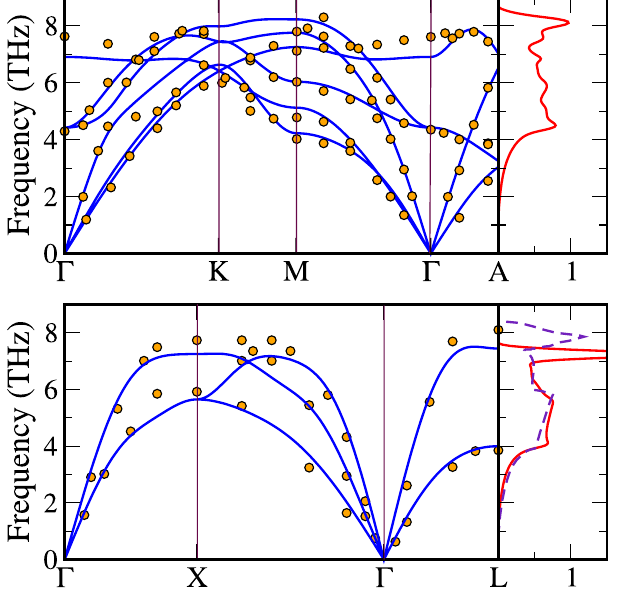
Figure 2. In the top-left panel the phonon dispersion relation along high symmetry lines for FM hcp Co is shown. The experimental values (dots) are taken from ref. 14. The calculated hcp phonon DOS is shown to the right of the figure. In the bottom-left panel the phonon dispersion relation along some high symmetry lines for FM fcc Co is displayed. The experimental values were obtained for Co 0.92 Fe 0.08 (dots) in ref. 15. The fcc phonon DOS and the calculated DOS obtained from the phonon spectra 15 (dashed-line) for fcc Co 0.92 Fe 0.08 are presented to the right of the